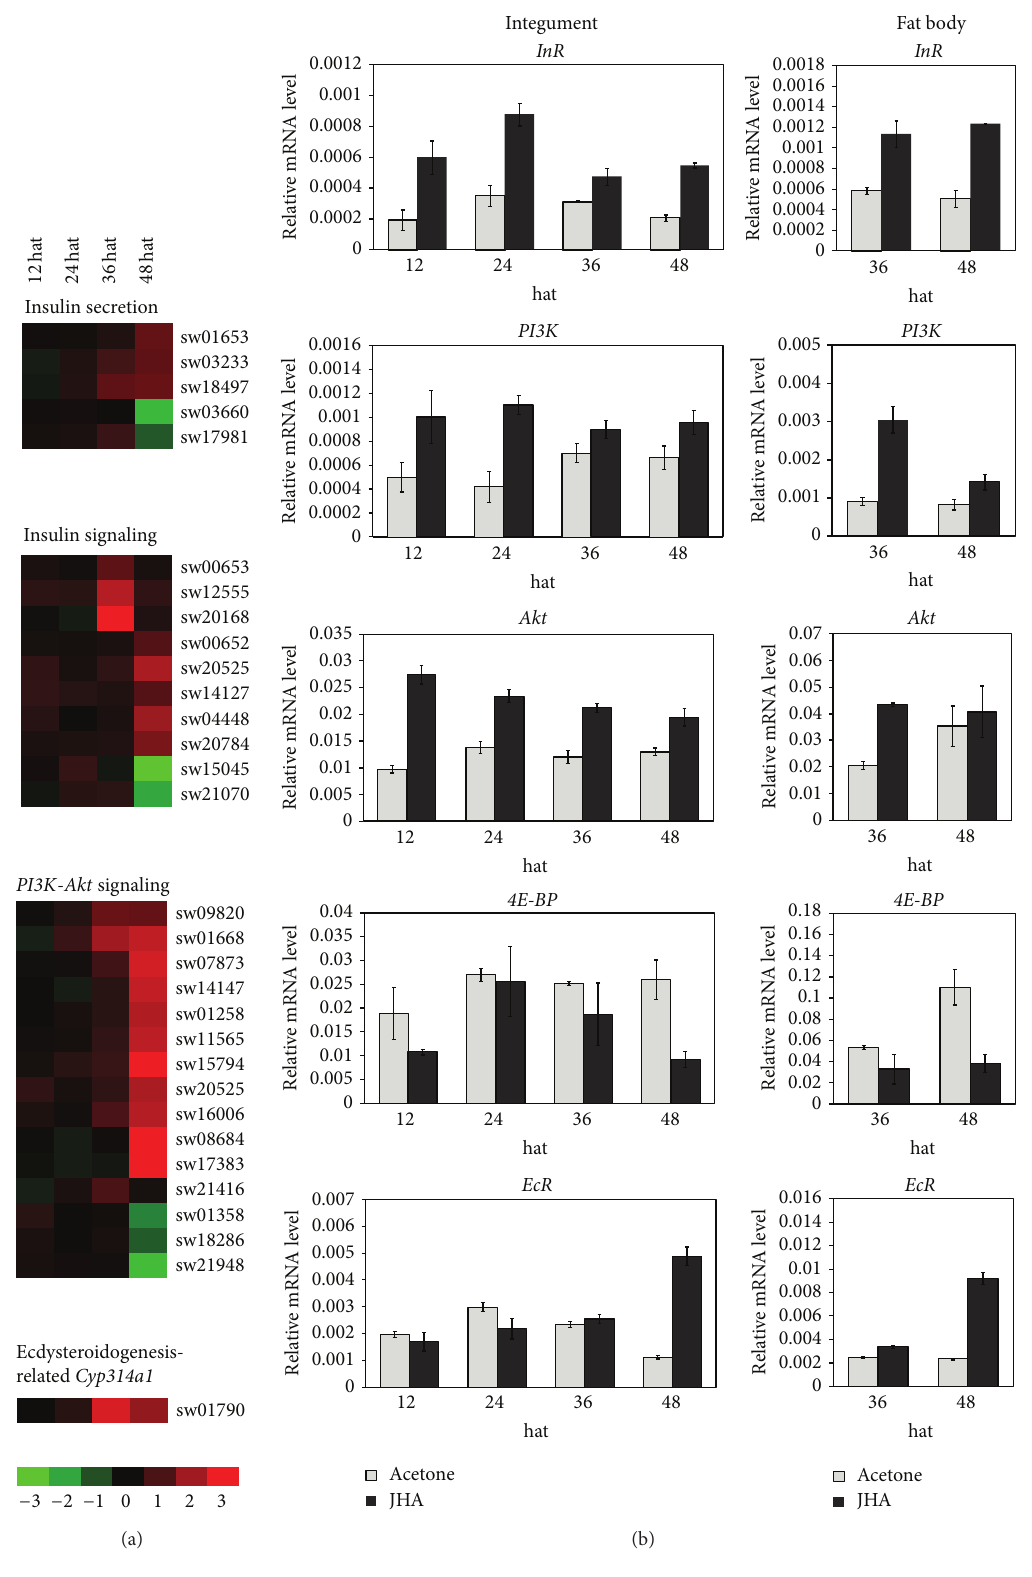
Figure 7: The IIS pathway is modulated by JHA. (a) Hierarchical clustering of JHA-modulated genes related to the IIS pathway and 20E biosynthesis. The probe ID, KEGG ID, and expression intensity of each JHA-modulated gene are listed in Tables S5 and S8. Hat: hours after treatment. (b) Real-time RT-PCR analysis of JHA modulation of the expression levels of key regulators involved in the IIS pathway and 20E